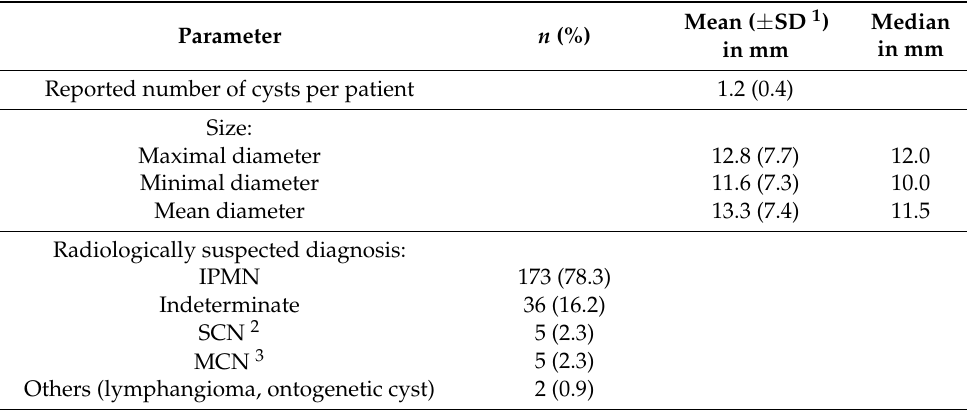
Table 1. Cyst size and most probable diagnosis as provided in the 221 radiology reports. Information on the exact number of PCLs and their size was provided in 199 and 194 reports, respectively. Minimal and maximal diameter represent the measurements of the cysts given on reports. An average diameter was calculated only if both were